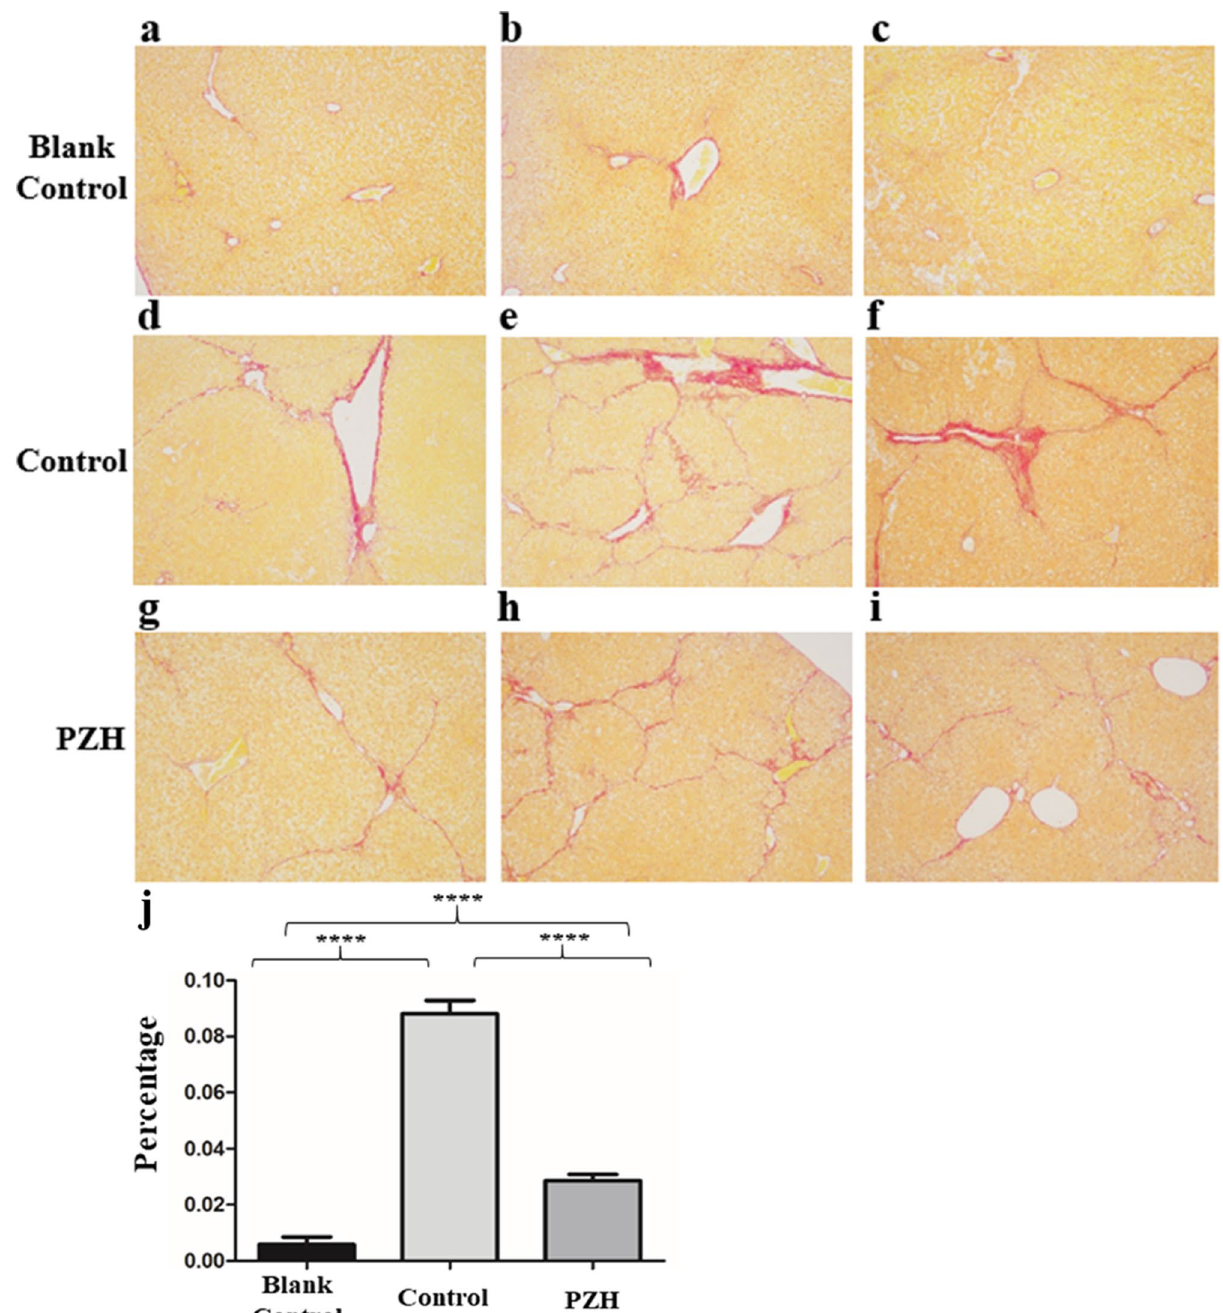
Figure 2. Sirius red staining results of hepatic fibrosis mice in the PZH and control groups at the time point of eighth week. ( a – c ) Three Sirius red staining results of the blank control group which received neither CCl 4 nor PZH. ( d – f ) Three Sirius red staining results of the control group which received CCl 4 . ( g – i ) Three Sirius red staining results of the PZH group which received both CCl 4 and PZH. ( j ) Was the percentage of positive area of Sirius red staining accounting for total area of blank control, control and PZH group ( ****P < 1.0 × 10 –4